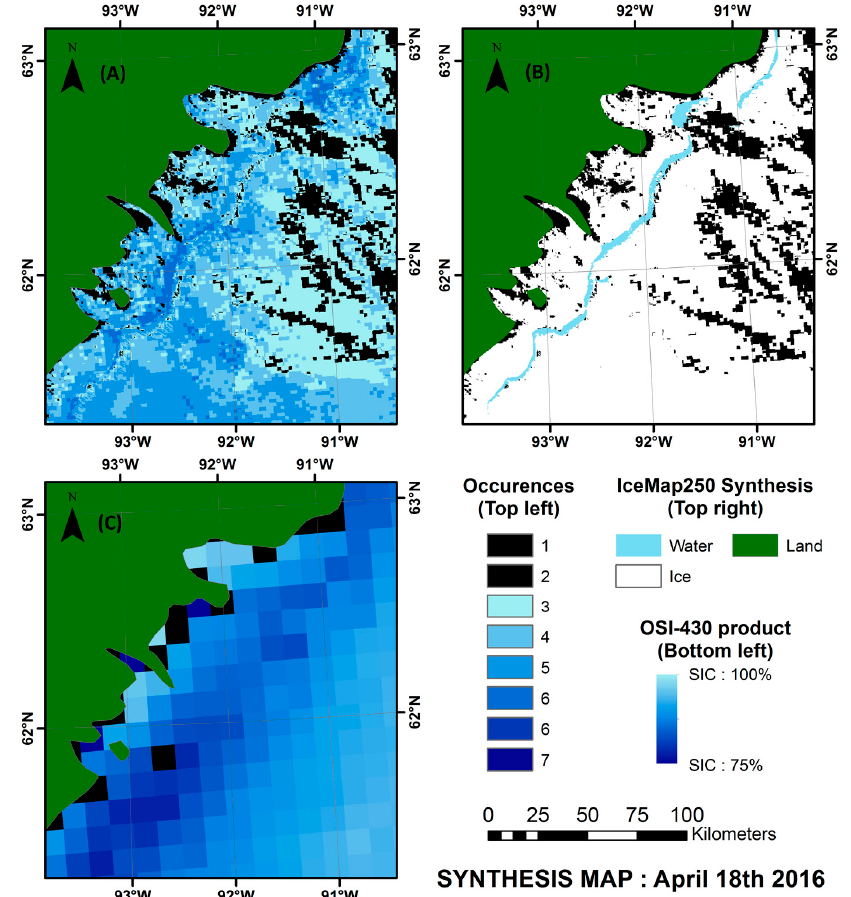
Figure 9. ( A – C ) Information occurrence map, IceMap250 7-days synthesis map (250 m), and OSI-430 (12.5 km) sea ice concentrations (SIC) for 18 April 2016. For the occurrence map, black pixels are pixels with less than 3 occurrences of data in the 7 days period. For the OSI-430 map, the black pixels are areas considered as land at the passive microwave data grid resolution.